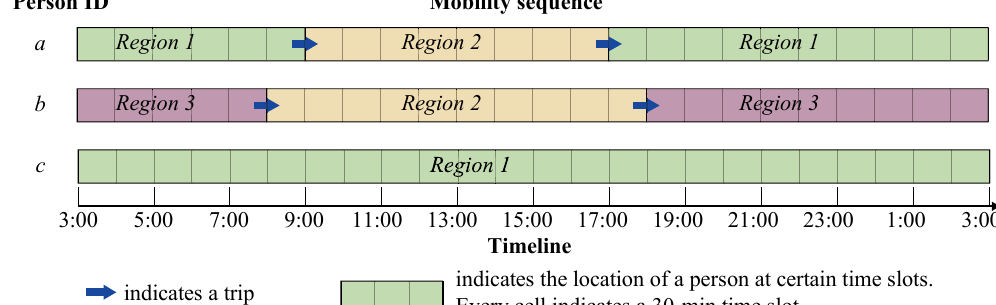
Figure 3. Mobility sequence.